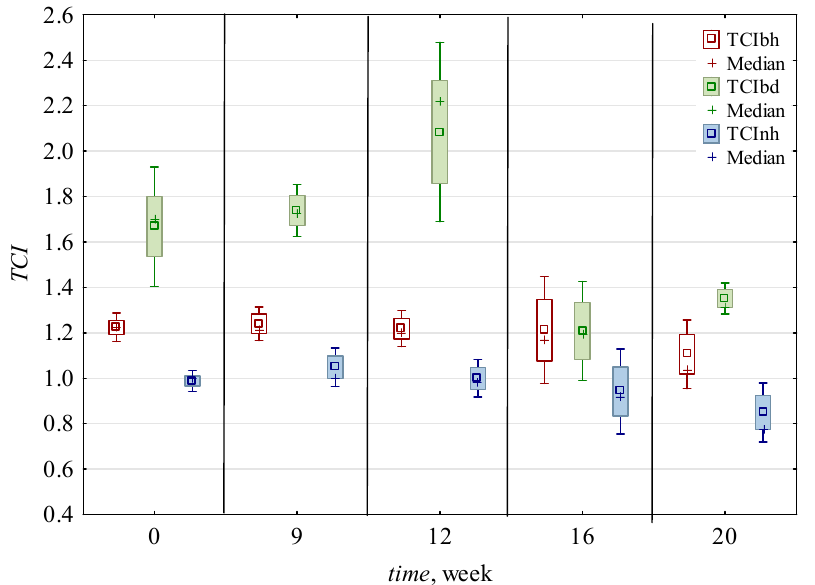
Figure 10. Values of CI : b —broad base, n —narrow base, h —peak height, d —peak deconvolution, □ —mean, frame —SE, and whisker —SD.